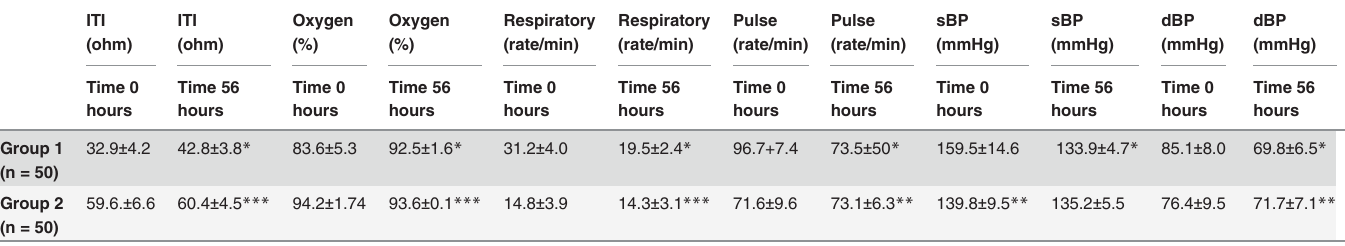
Table 2. Differences between the values of clinical parameters at baseline and at the end of